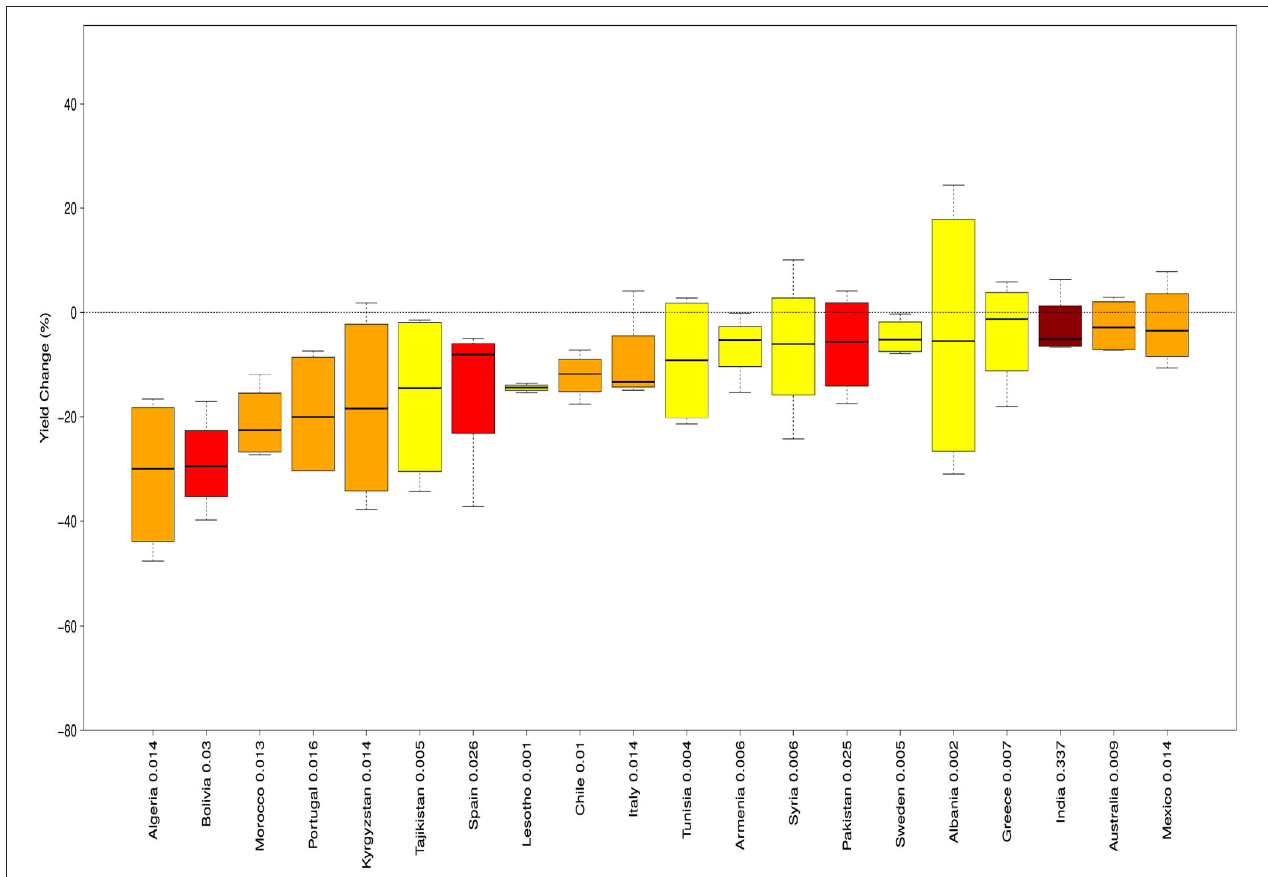
FIGURE 6 | Countries associated with the 20 largest decreases in mean yields across climate models from the baseline to 2040–2060, with ranges across climate models, for the non-adaptation simulations. Boxplots show medians, interquartile ranges and the whiskers extend to 1.5 times the interquartile range. Dark red boxes show top 10 countries for growing area, light red = top 25, orange = top 50%, and yellow = bottom 50%. Numbers next to country names refer to the normalised growing area for each country, with a value of 1 indicating the largest growing area in one country, which is 4,394,406 ha in